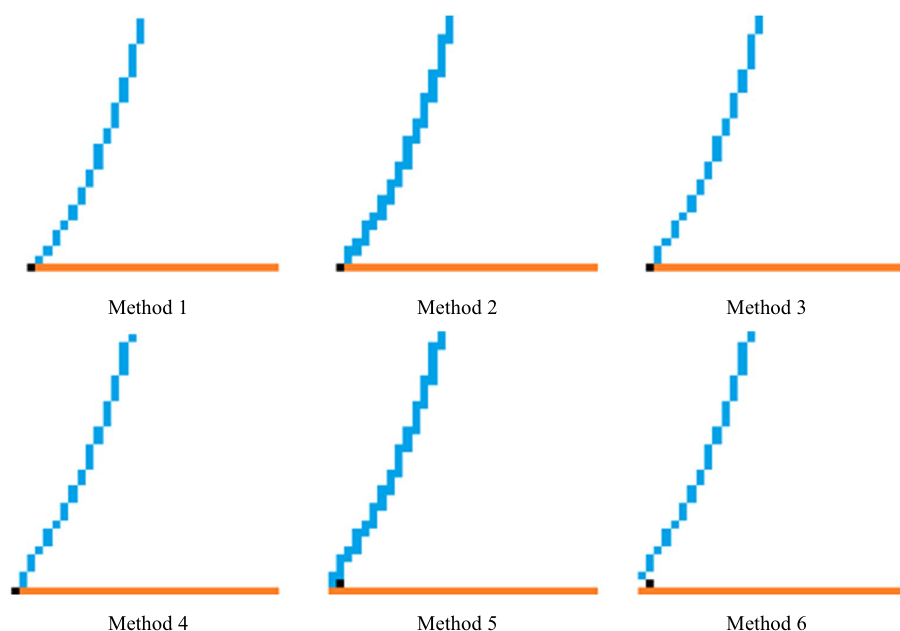
Fig. 2 Methods for pixel selec-